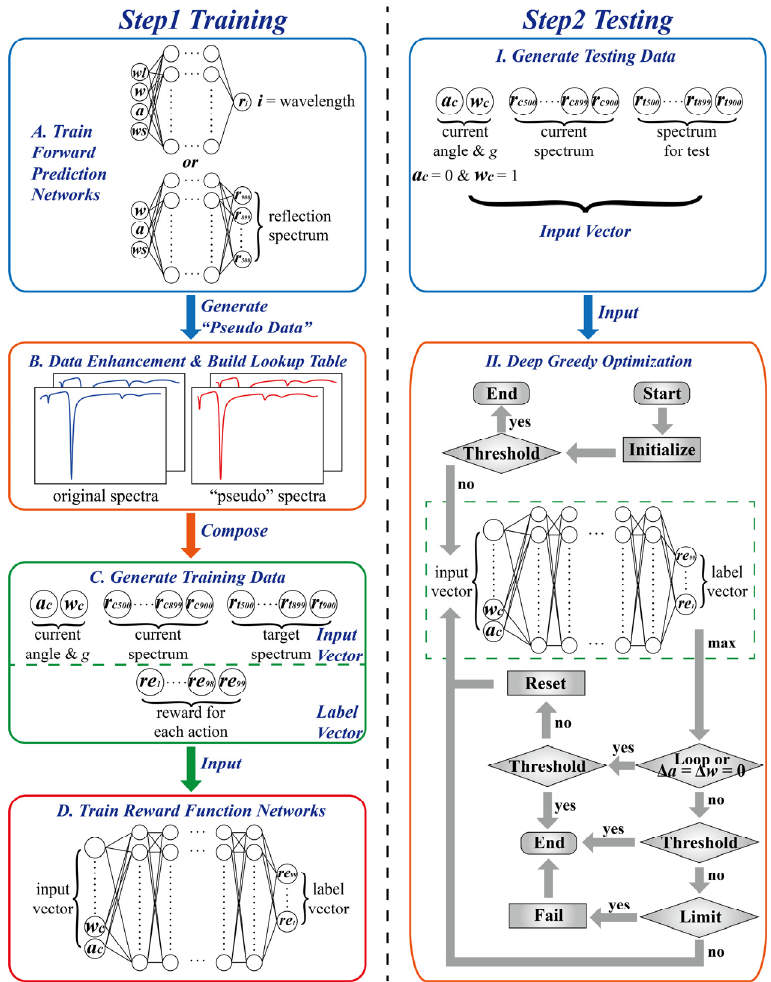
Figure 3. Schematics of the DEDGO algorithm for the efficient inverse design of multiple hetero ‐ junctions. The algorithm can be divided into two main stages, namely, training (left) and testing (right). The first stage is applying the forward prediction networks to intensify the dataset ( A , B ) and training the reward function networks for the next part ( C , D ). The second part is utilizing the trained reward function networks to predict structural parameters for heterojunctions in a gradual optimization way ( I , II ).